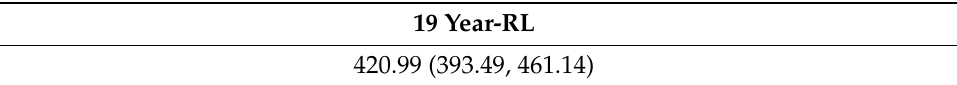
Table 4. Estimate and its 95% CI of the 19 year-RL with bootstrapping in GP distribution.